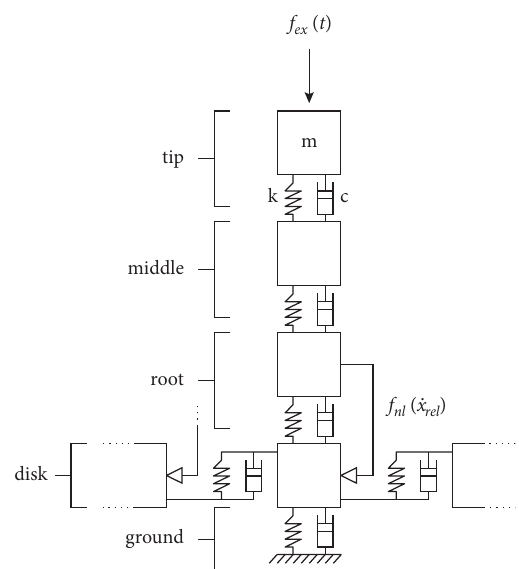
Figure 2: Fundamental sector of the model provided by reference [40].